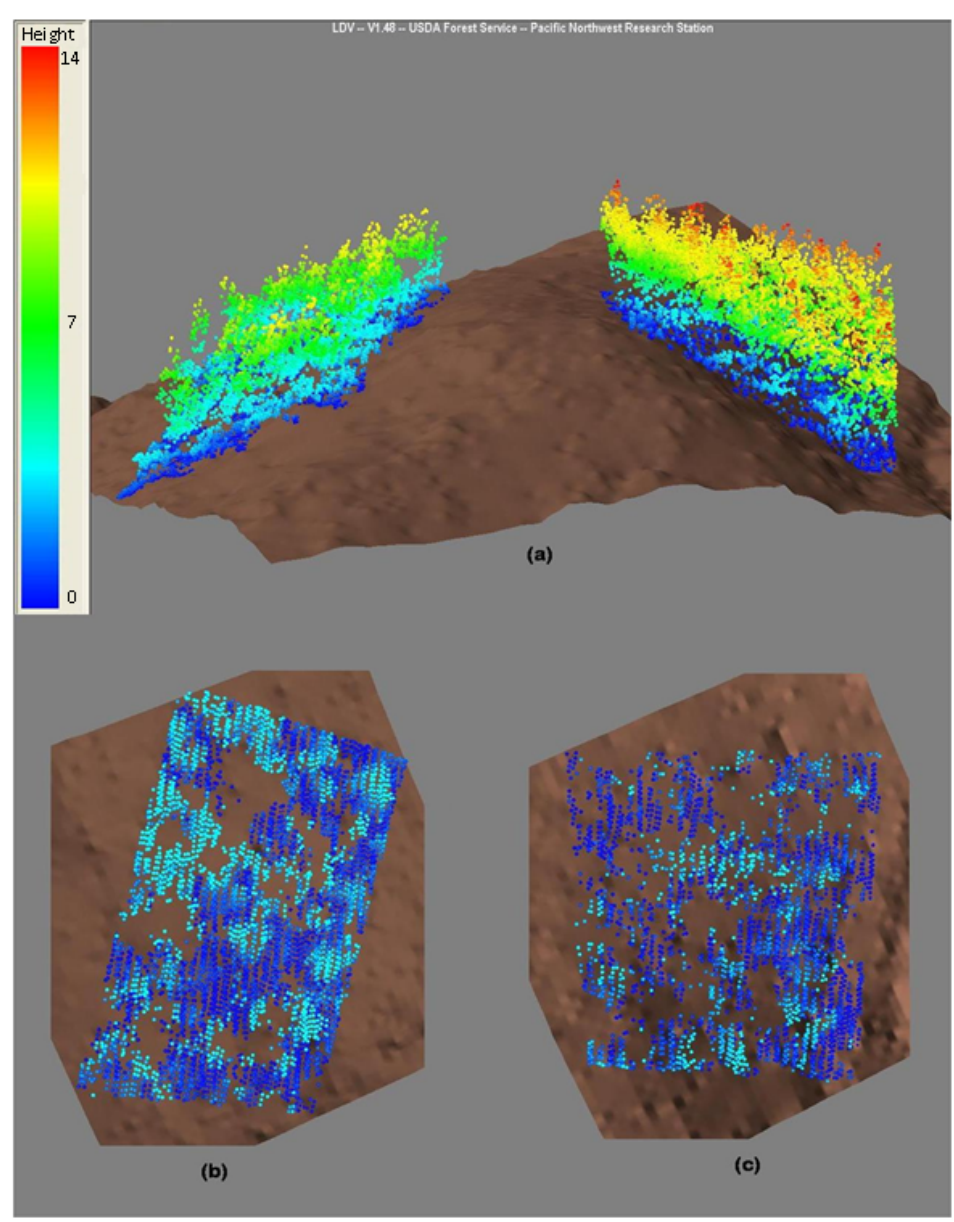
Figure 4. LiDAR point clouds colour coded by vegetation height for low (top left) and high (top right) leaf area index plots: ( a ) all returns with ground surface model; ( b ) overhead view of points within 3 m of the ground surface in low LAI plot; and ( c ) overhead view of points within 3 m of the ground surface in high LAI